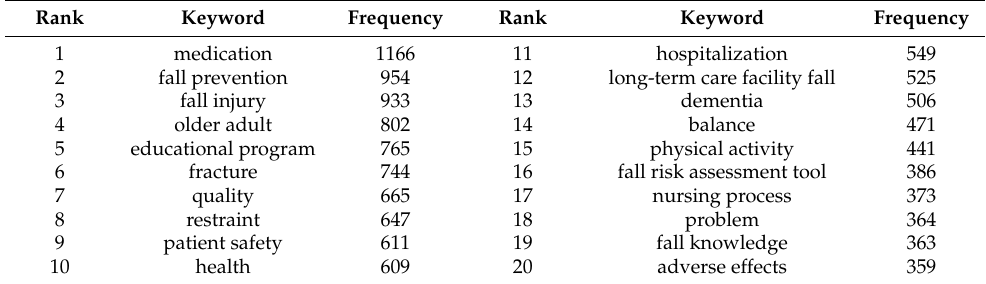
Table 1. Core keywords by